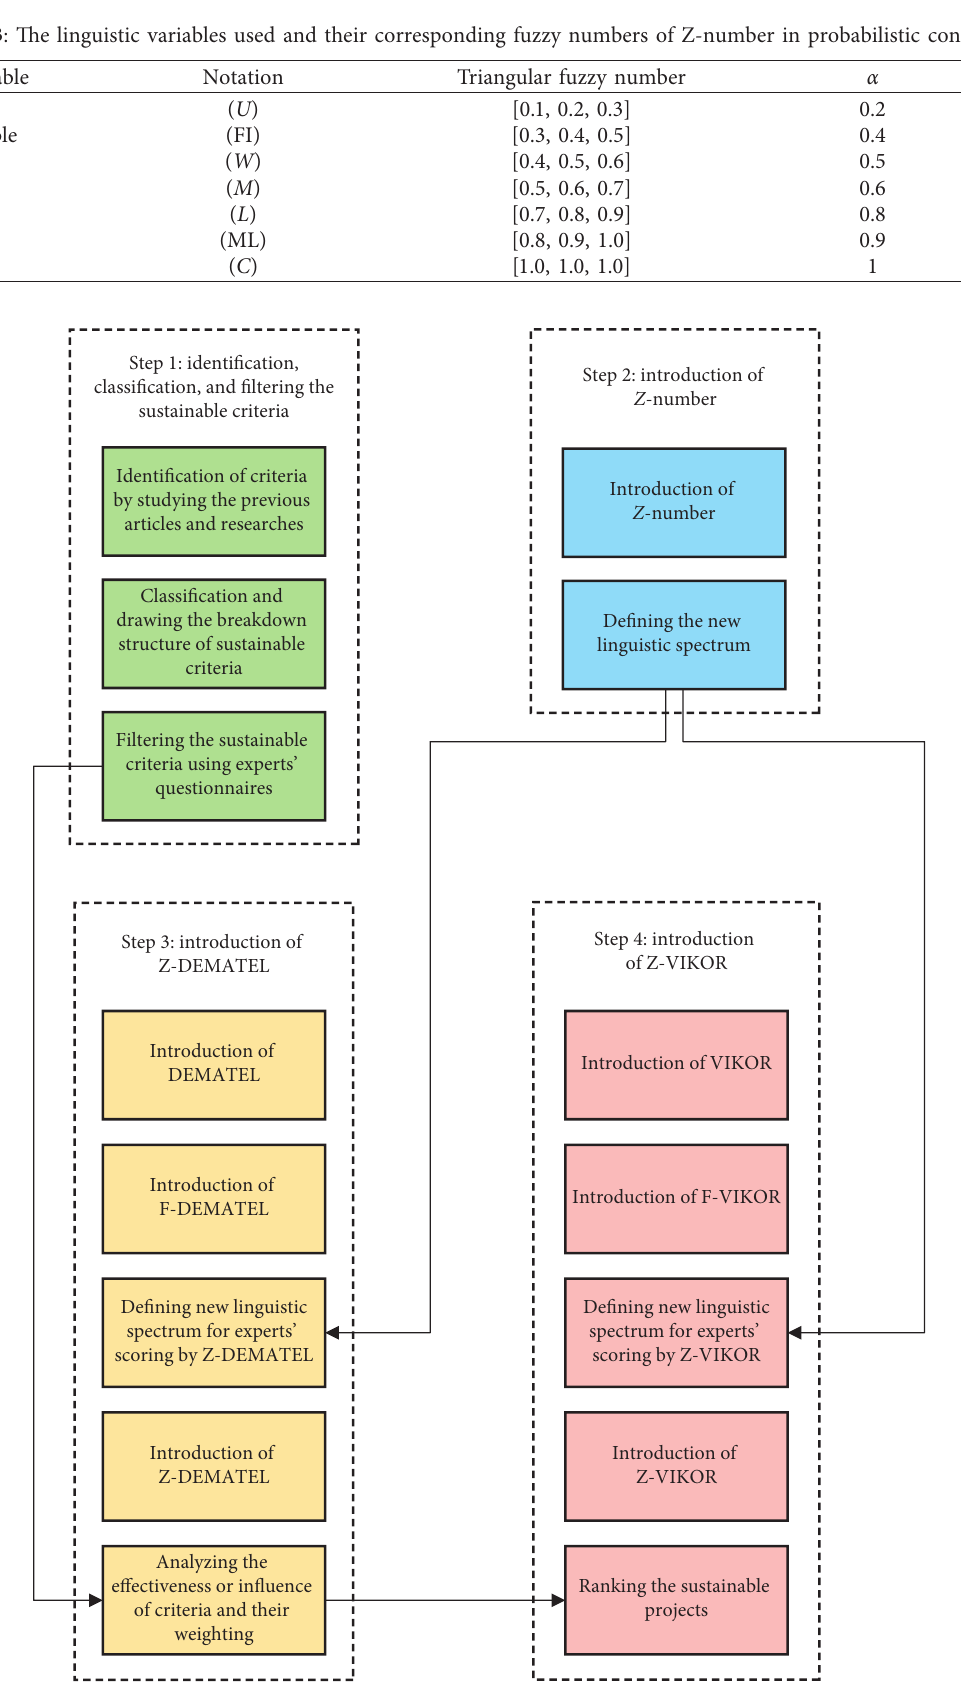
Figure 5: Research method process.